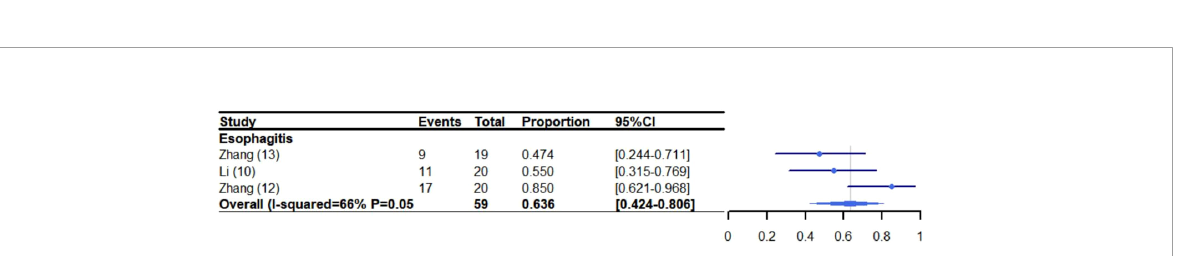
FIGURE 5 Meta-analysis and forest plot for patients who experienced esophagitis receiving CRT/RT and ICIs. CRT: Chemoradiotherapy; RT: Radiotherapy; ICIs: Immune checkpoint